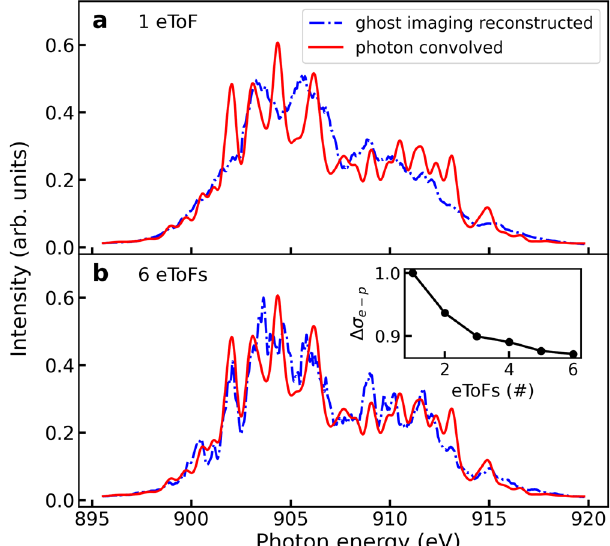
Fig. 6 Improved single-shot reconstruction as a function number of electron time-of- fl ight spectrometers (eToFs) used. The reconstructed spectrum and Gaussian convolved spectrum using one eToF ( a ) and six eToFs ( b ). All the shots are used to get a converged result. The inserted plot shows the decrease in Δ σ e-p (Eqn. (3)) when more eToFs are